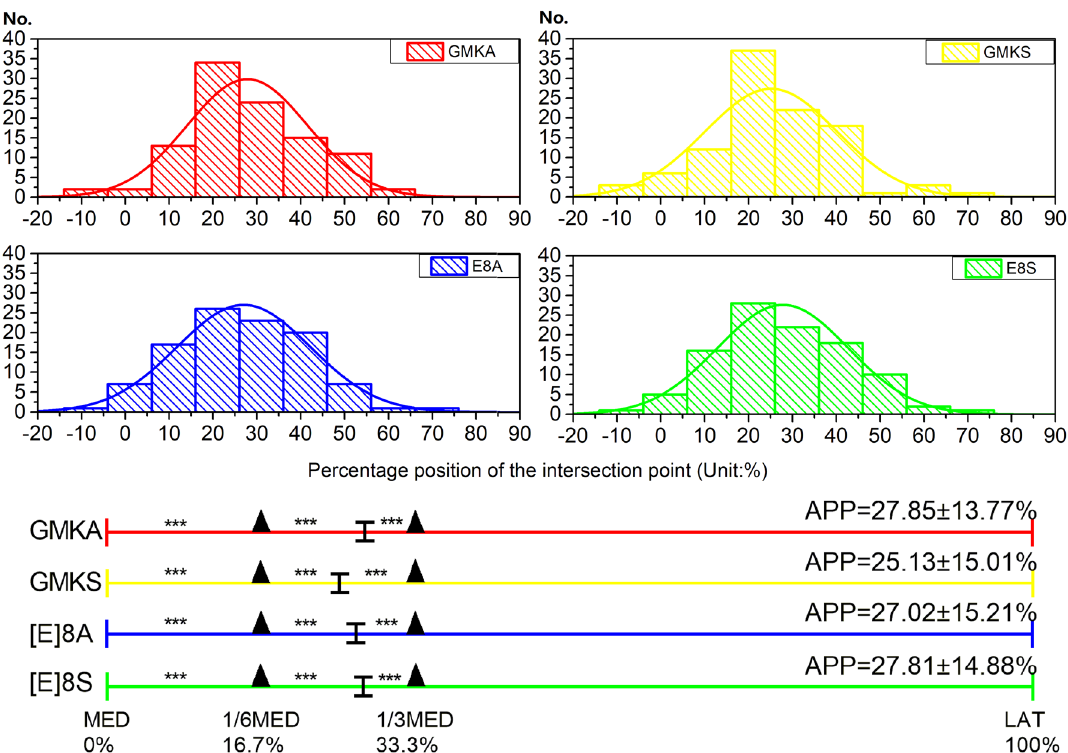
Figure. 5. Distribution of the percentage position of the baseplate AP axis over the patellar tendon. The average percentage position (APP) was 26.95 ± 14.71% of the full patellar tendon from medial edge. Curve line in colors indicated the normal distribution. The positive value represented the lateral position. No. the count number of the subjects, GMKA the Gemini Mobile Knee anatomic design, GMKS the Gemini Mobile Knee symmetric design, [E]8A the [E]8 anatomic design, [E]8S the [E]8 symmetric design. MED medial edge of the patellar tendon, 1/6MED medial 1/6 of the patellar tendon, 1/3MED medial 1/3 of the patellar tendon, LAT lateral edge of the patellar tendon. ***p < 0.001 (Paired T